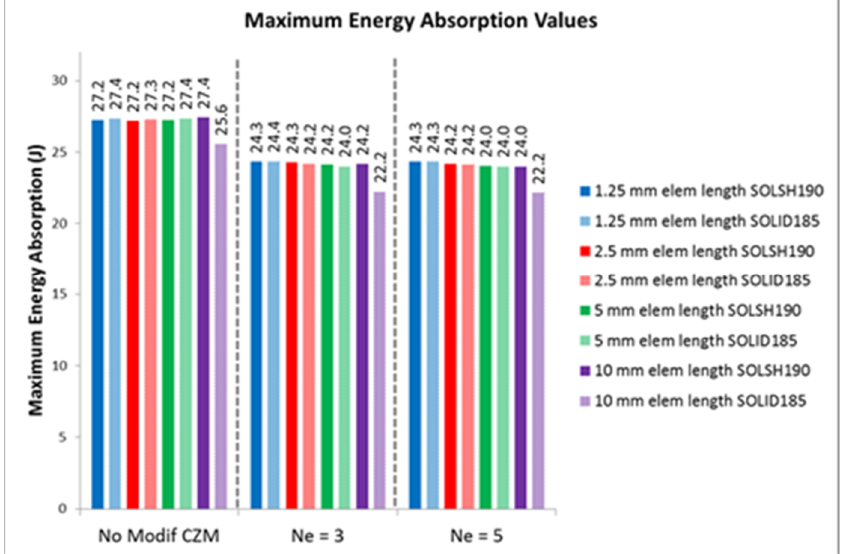
Figure 7. FE results of the maximum energy absorption values of the specimen examined.